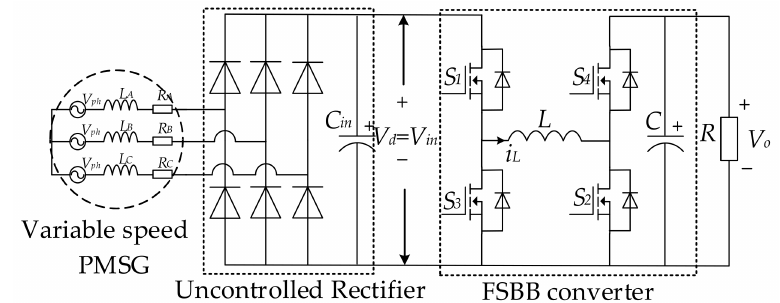
Figure 2. Circuit structure for storage system with FSBB converter.